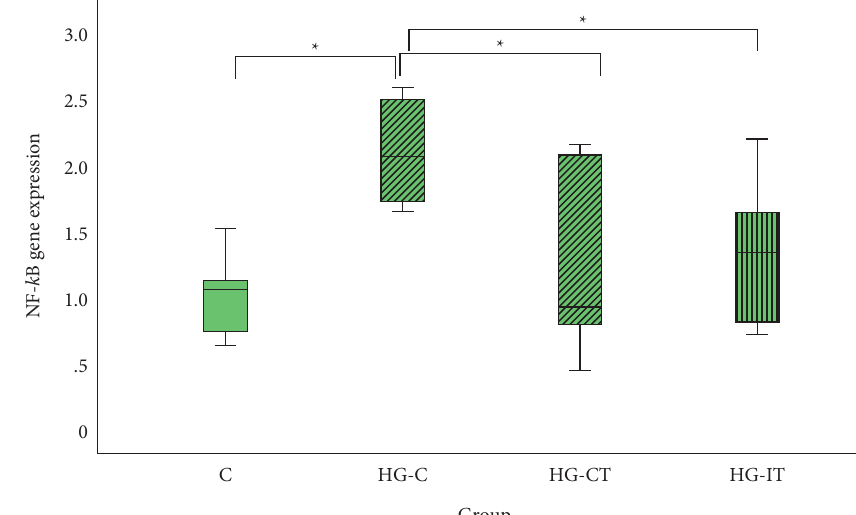
Figure 8: NF- κ B gene expression within each group. c: control group; HG-C: hyperglycemic control group; HG-CT: hyperglycemic rats that performed moderate-intensity continuous training (MICT); HG-IT: hyperglycemic rats that performed high-intensity interval training (HIIT). Te error bars represent the standard deviation of measurements. ∗ p < 0 .